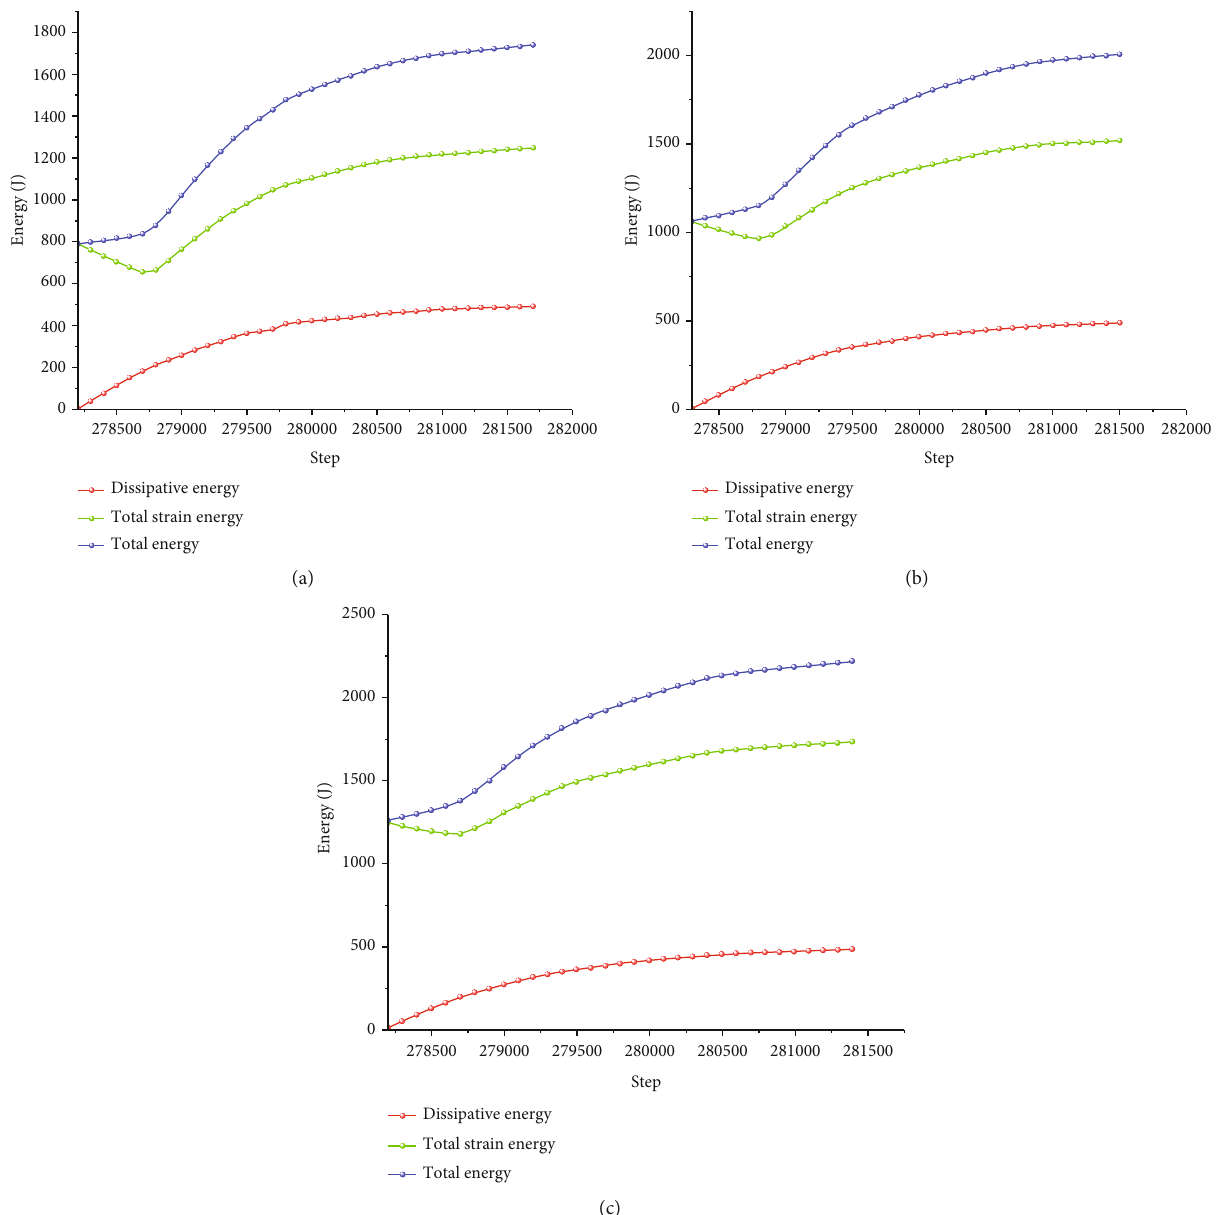
σ V = 50MPa, H = 60MPa . (b)